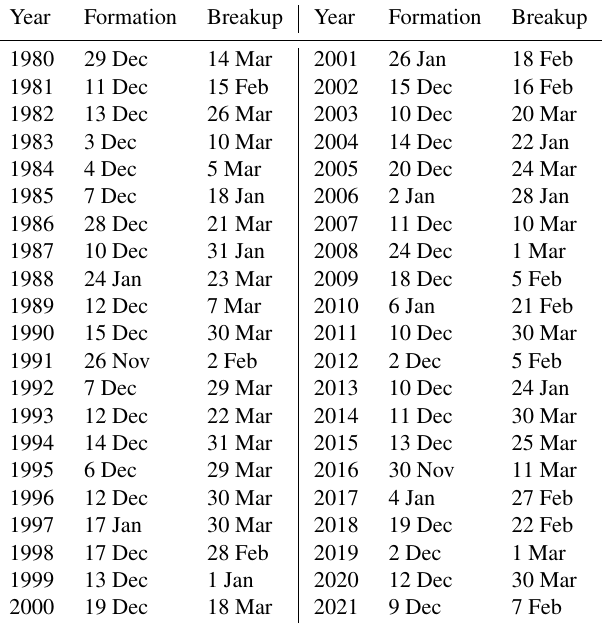
Table 3. Assumed dates of vortex formation and breakup in the Northern Hemisphere.